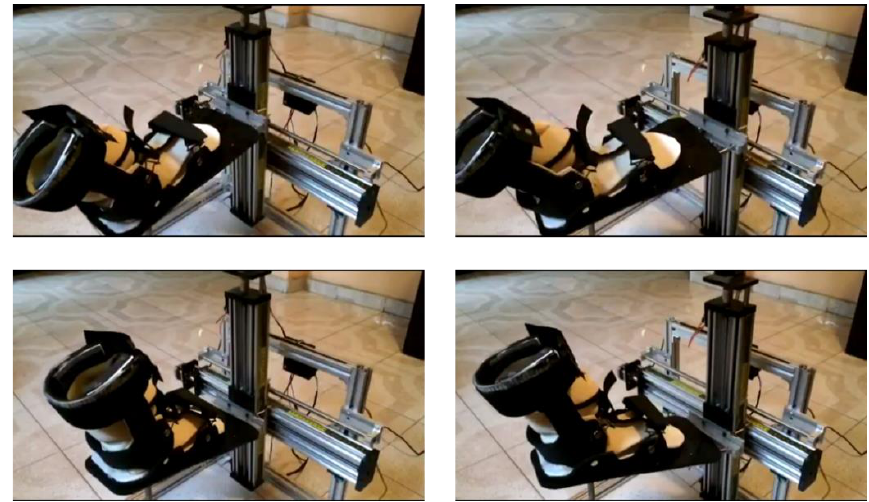
Table 7. G code for rehabilitation movements.